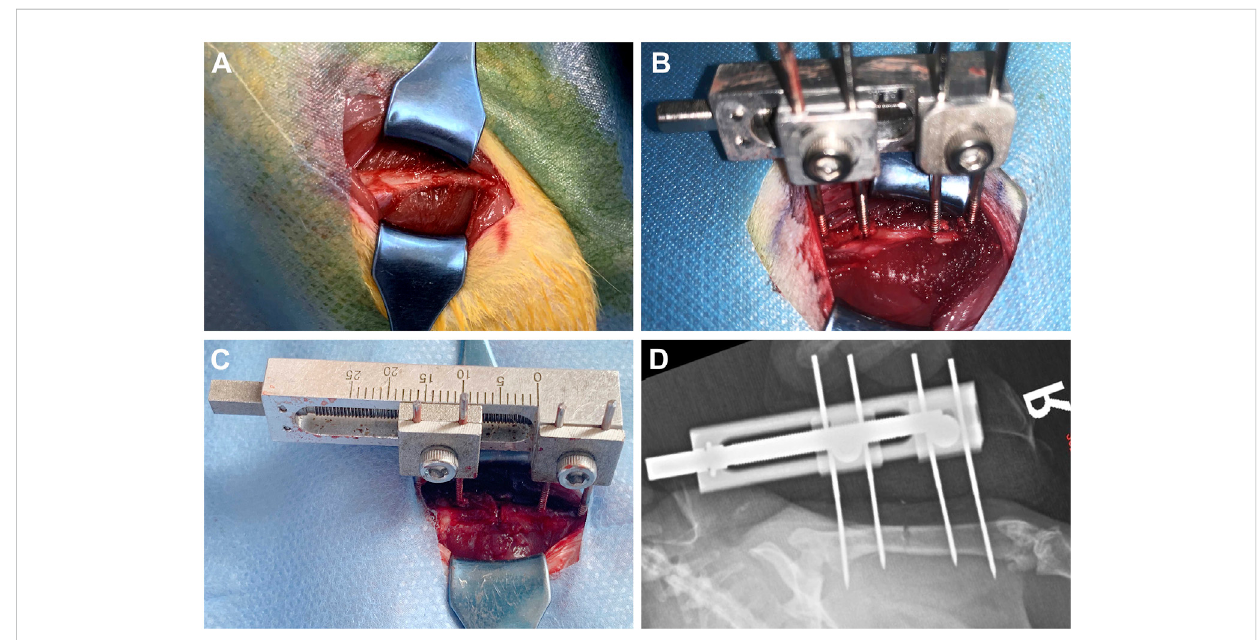
FIGURE 2 Schematic diagram of the operation of rat right femoral distraction osteogenesis model. (A-C) The surgical procedure. (D) X-ray examination after